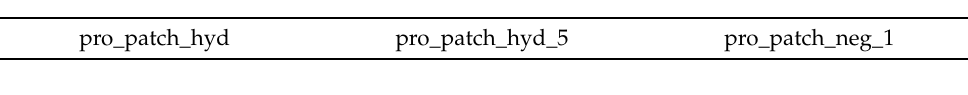
Table 7. Common selected features between ADRB2 and OPRK1 having a feature score of